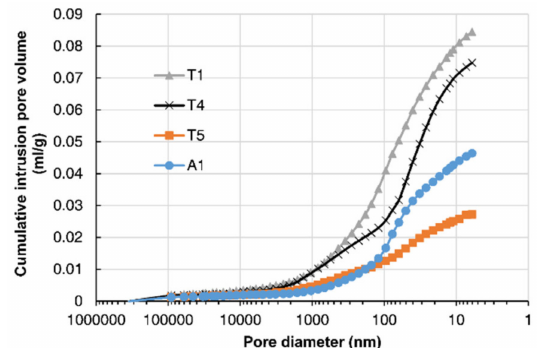
Figure 6. Cumulative intrusion pore volume measured by MIP.